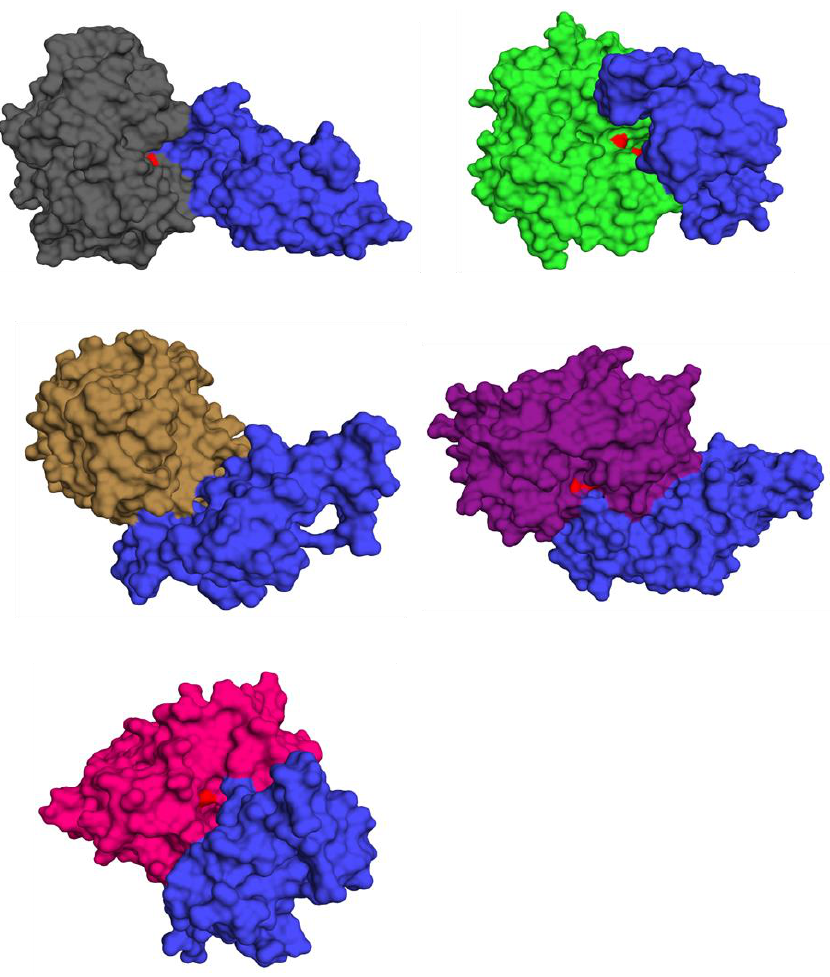
Figure 8. Structures of cystatin C (blue) – cysteine protease complexes with clear blocking of the protease active sites (red). Papain depicted in gray, cystatin B in green, cystatin H in brown, cystatin L1 in purple, and cystatin S in pink.